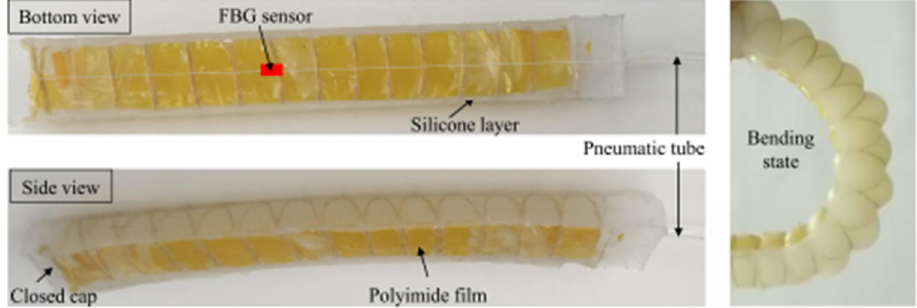
Figure 24. A pneumatic soft actuator employing a FBG curvature sensor to measure the deformation of the soft actuator [145] (Open Access).